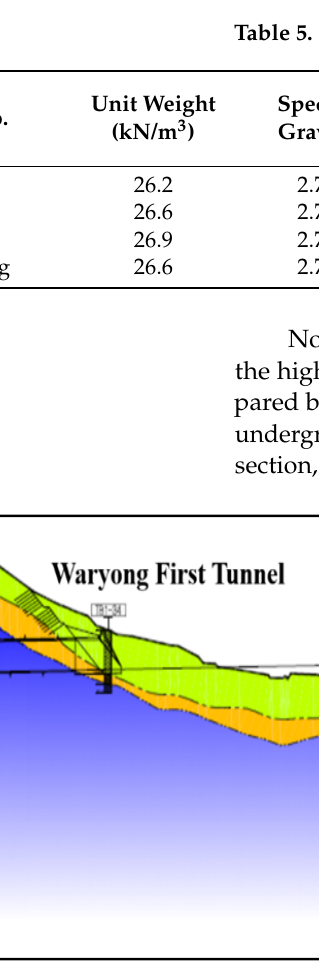
Figure 19. Longitudinal cross section along the railway embankment.